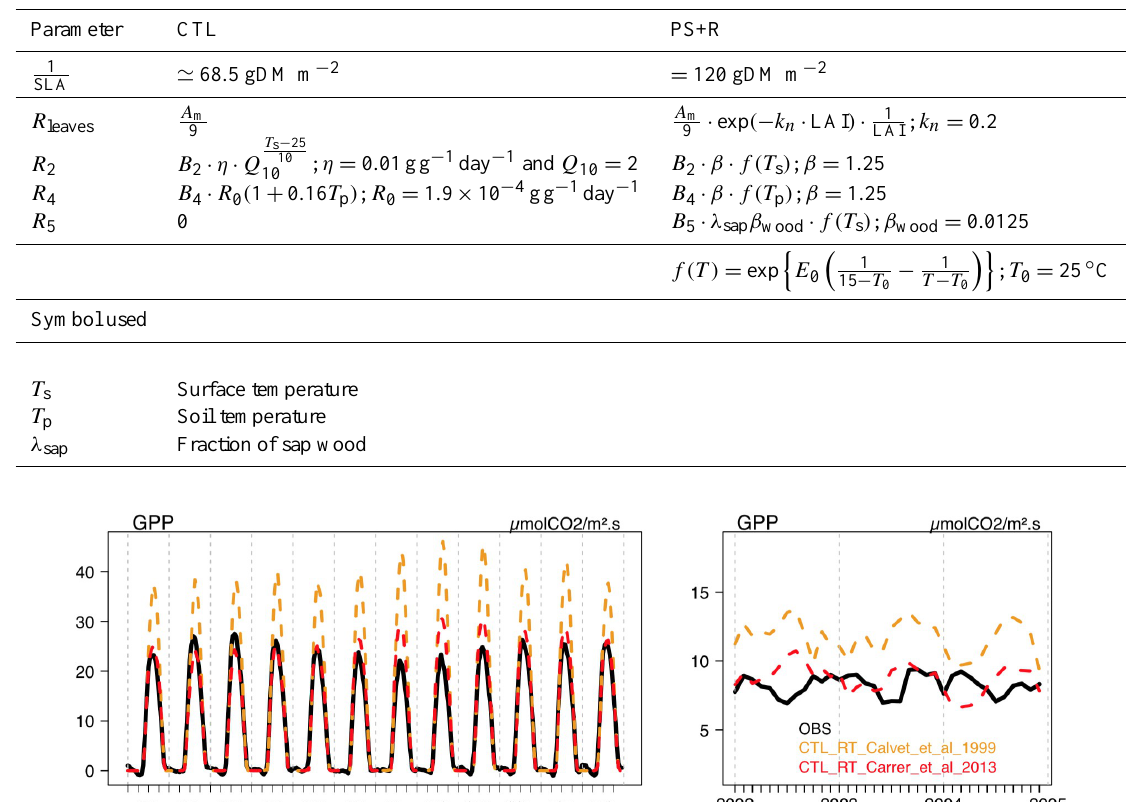
Figure 2. Observed and simulated GPP with the CTL version of ISBA CC comparing the two radiative transfers at K67. The left panel shows the diurnal cycle for each month averaged over 3 years (2002–2004); the right panel shows the monthly mean time series for